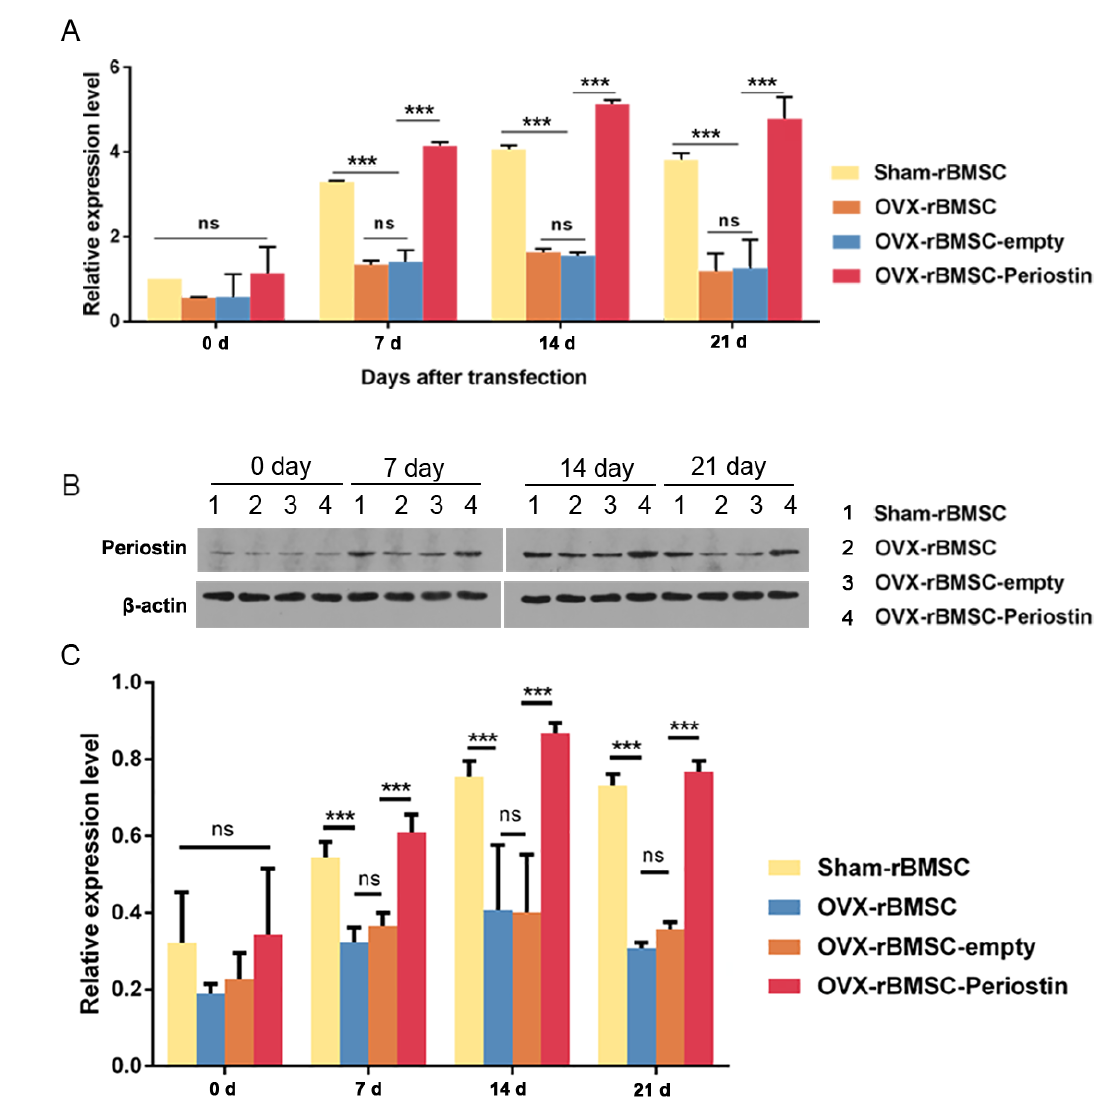
Figure 4 ‒ Overexpression of periostin elevated periostin mRNA and protein levels after osteogenesis induction. (A) The graph shows the quantification of the relative expression levels of periostin in the indicated groups on day 0, day 7, day 14 and day 21 after osteogenesis induction. (B) The expression levels of periostin in the indicated groups on day 0, day 7, day 14 and day 21 after osteogenesis induction were investigated using western blotting; β-actin served as the reference gene. The image is representative of 3 independent experiments. (C) Quantitative western blotting was performed using Image J software. Data are presented as the mean ± SD of 3 independent experiments. ns, not significant. *** P < 0.001; One-way